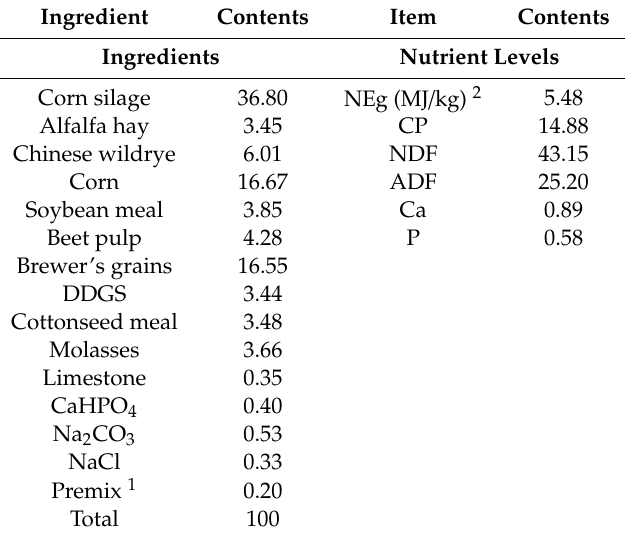
Table 1. Basal diet composition and nutrient levels (DM basis,